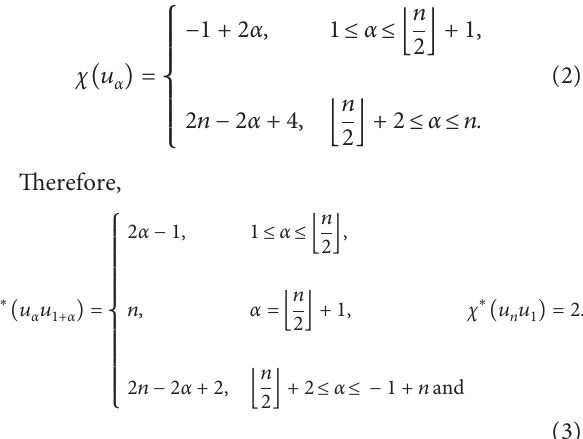
Figure 2. Hence, every cycle C n and its line graph L ( C n ) are classical mean graphs, for n ≥ 3.